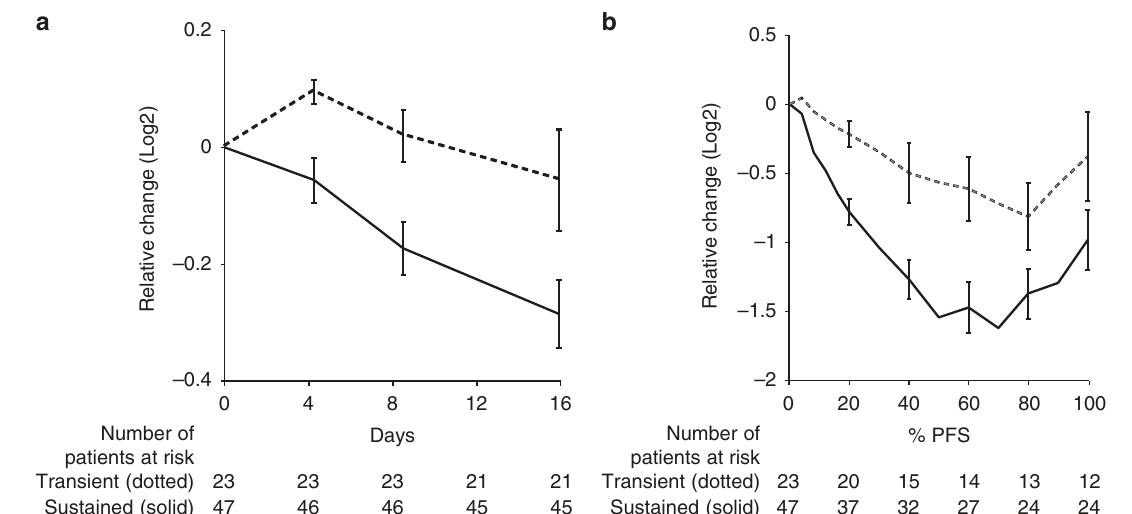
Fig. 4 Prognostic value of angiogenic biomarkers. The association between a less profound reduction in Tie2 and higher K trans :VEGFR2 ratio (Fig. 2b) identi fi ed a poor prognostic group. The WTV derived from DCI-MRI of this poor prognostic group (dotted lines) was compared with better prognostic outcome group (solid lines). a Shows the differential impact of single agent bevacizumab (10 mg/kg) on WTV between the two groups up to 15 days after treatment, with effects emerging by day 4 ( P = 0.029, Mann – Whitney U test). b Volumetric analysis showed persistence of this difference throughout the course of combined cytotoxic chemotherapy and bevacizumab, with changes in WTV plotted using the same groups against the percentage time that elapsed between randomization and the date of progression/censoring (%PFS; P = 0.012, Mann – Whitney U test). Error bars indicate the standard error. WTV; whole tumor volume, DCE-MRI; dynamic contrast-enhanced magnetic resonance imaging, VEGFR2; vascular endothelial growth factor receptor